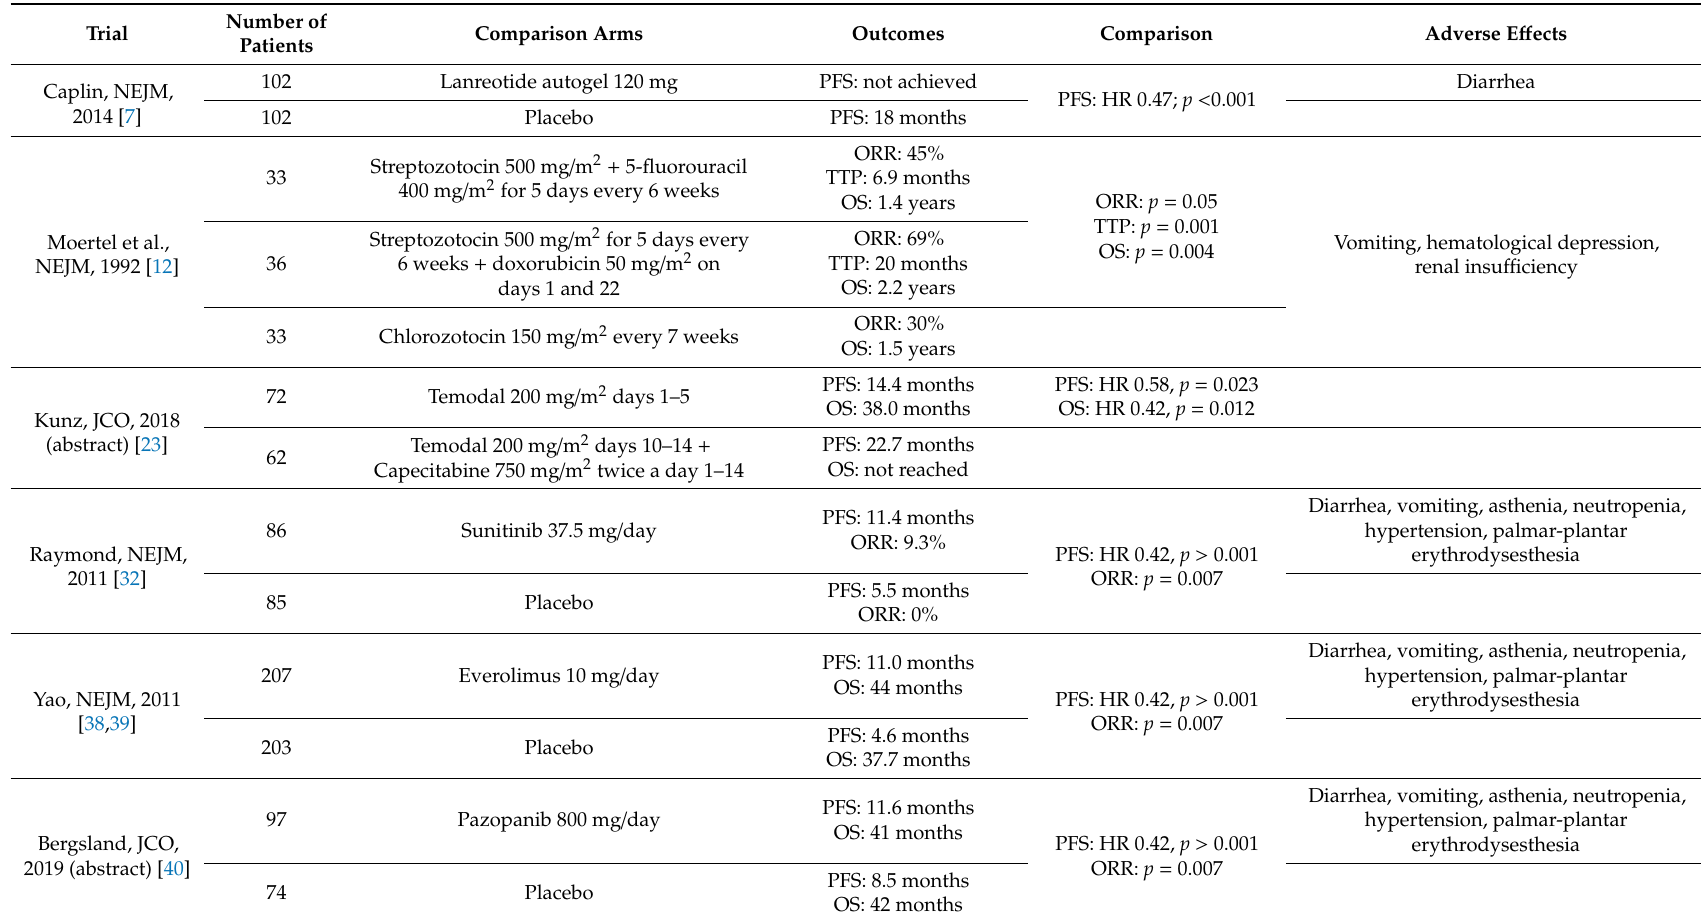
Table 3. Randomized clinical trials (randomized phase II and phase III trials) in panNENs. Comparison Arms Outcomes Comparison Adverse E ff